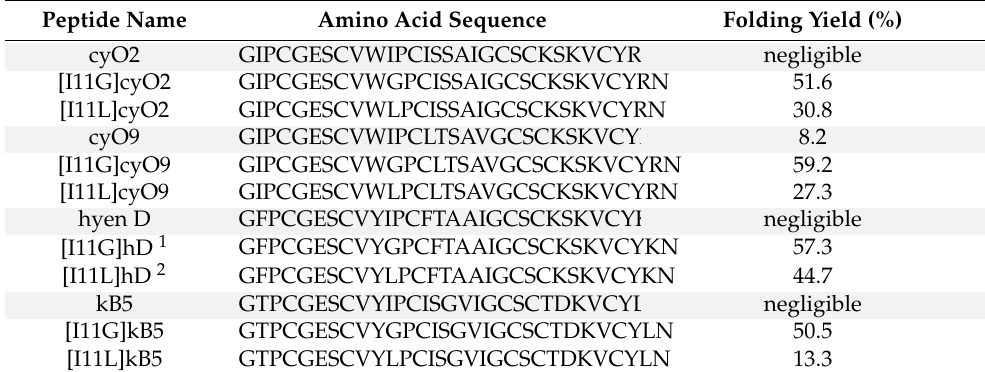
Table 1. Sequence and folding yield (%) of selected bracelet cyclotides and their